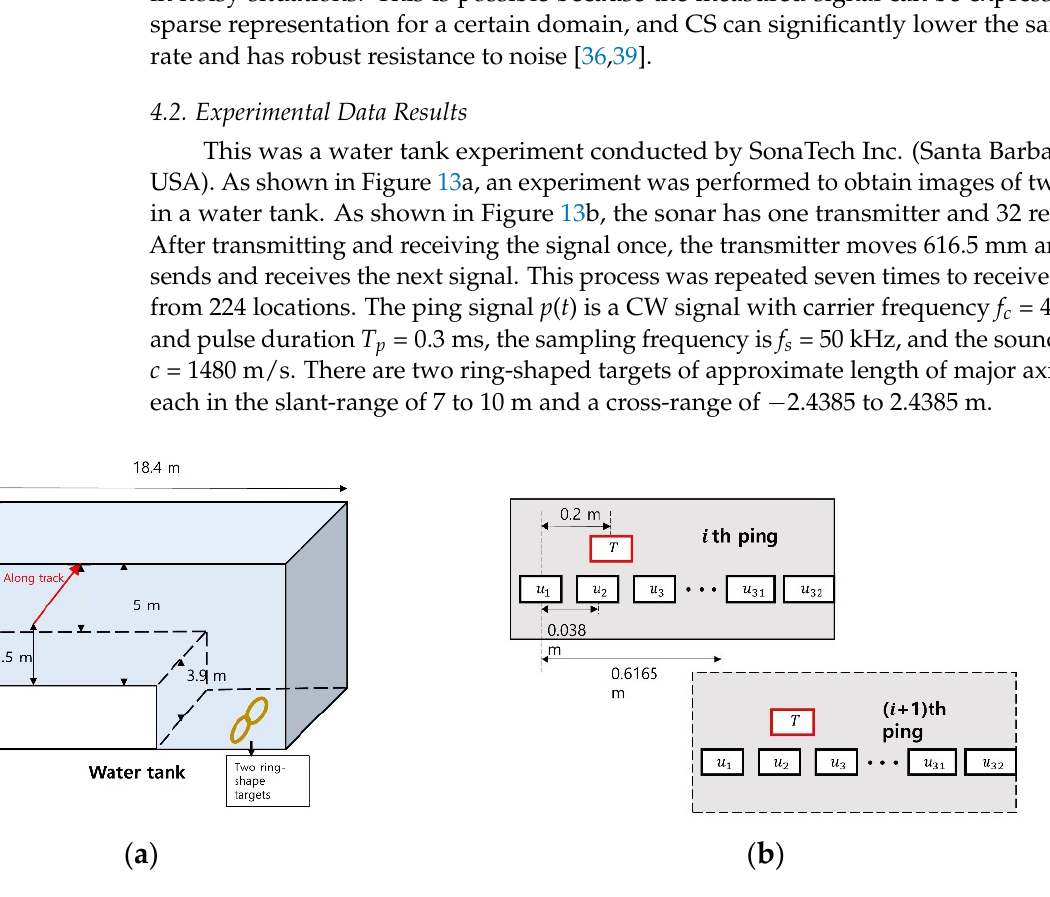
Figure 14. ( a ) Raw data; ( b ) result for the ω -k algorithm; ( c ) result for the CS-SAS algorithm. From the raw data, the targets can be seen in the form of rings, but the shape appears thick, and it is difficult to accurately determine the location of the targets. In the results of the ω -k algorithm, the shapes are slightly thinner, but aliasing is severe in the azimuth